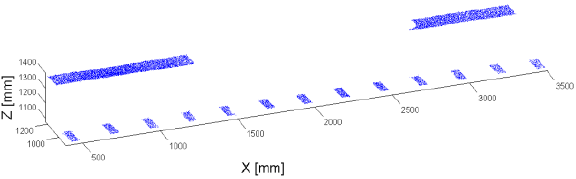
Figure 8. Example 3D point cloud derived from the photogrammetric reconstruction